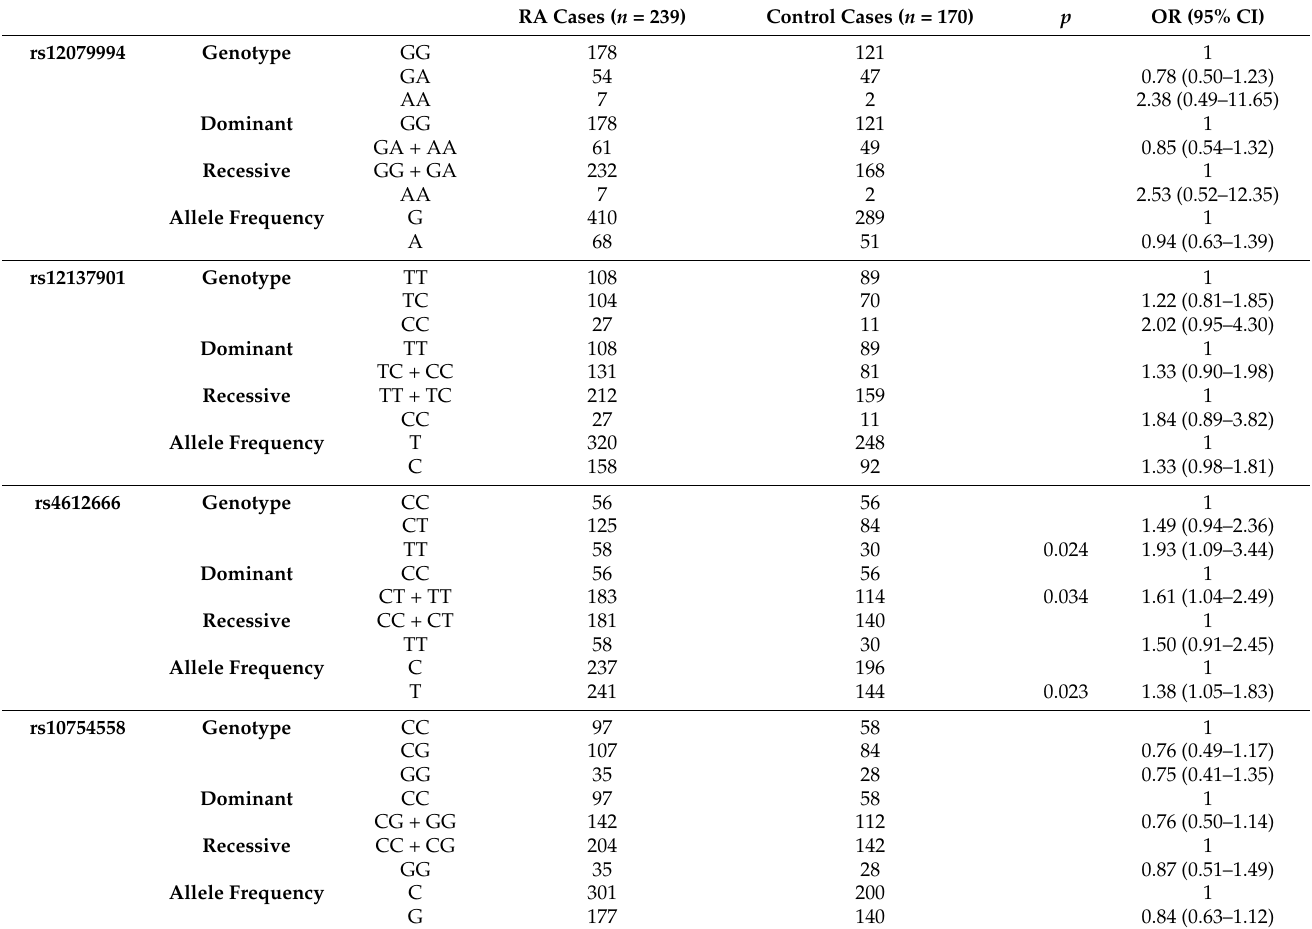
Table 1. Genotypes and allele frequency of NLRP3 gene in RA